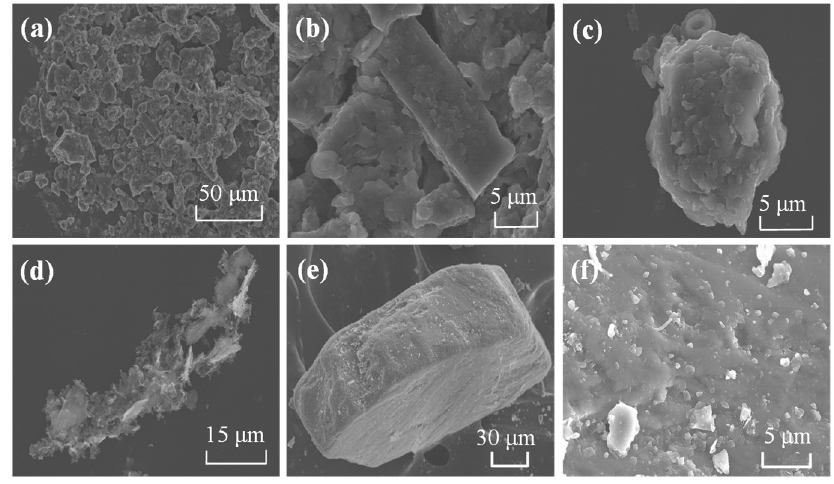
Figure 8. SEM images of sediments: ( a – d ) Clayey-silt sediment; ( e , f ) sand sediment. At low hydrate saturation, the effect of hydrate on strength parameters is limited because of the low cementation among sediment particles induced by hydrate formation.